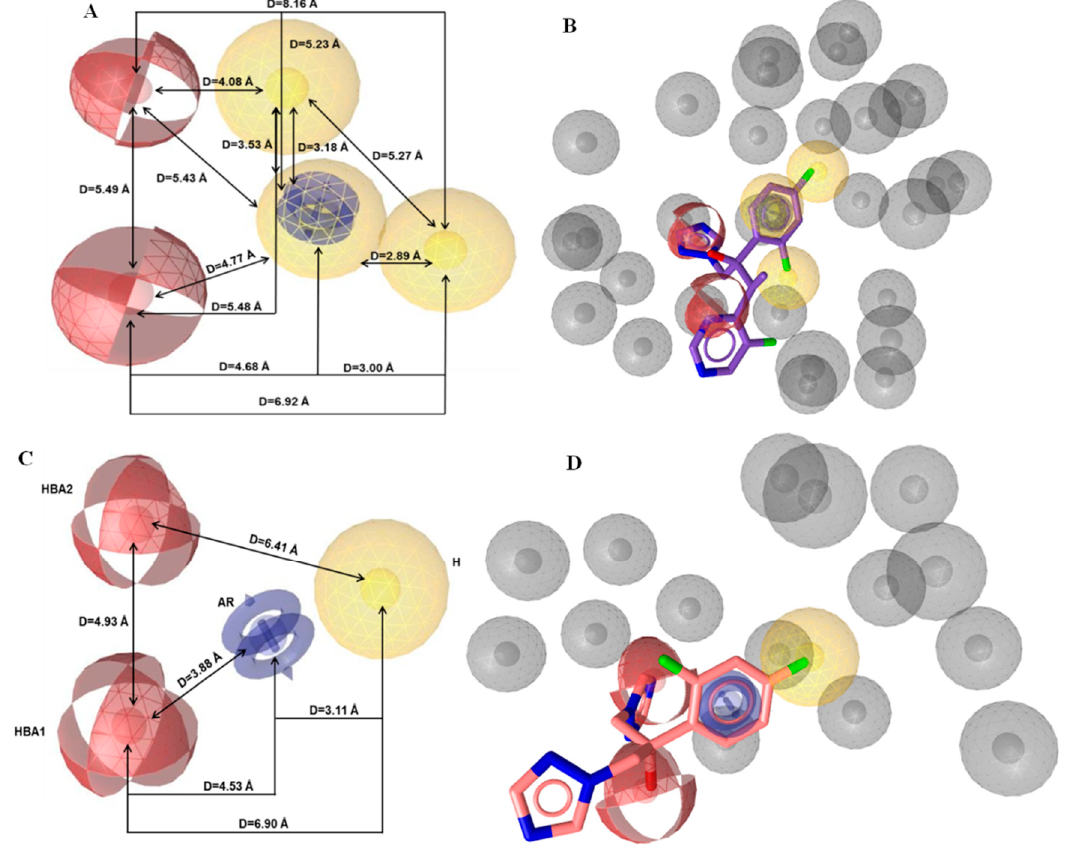
Figure 4. Representation of ( A ) the initial and ( C ) the optimum pharmacophore model features. Fitted of ( B ) voriconazole on the initial pharmacophore features and ( D ) fluconazole on the optimum pharmacophore features. The depiction of the features is colored as follows: hydrogen bond acceptors (HBA) as red spheres, hydrophobic regions (H) as yellow spheres, aromatic rings (AR) as blue rings, and exclusion volumes (Ex. Vol.) as grey spheres. The distances (Å) between the chemical features are illustrated as black lines.